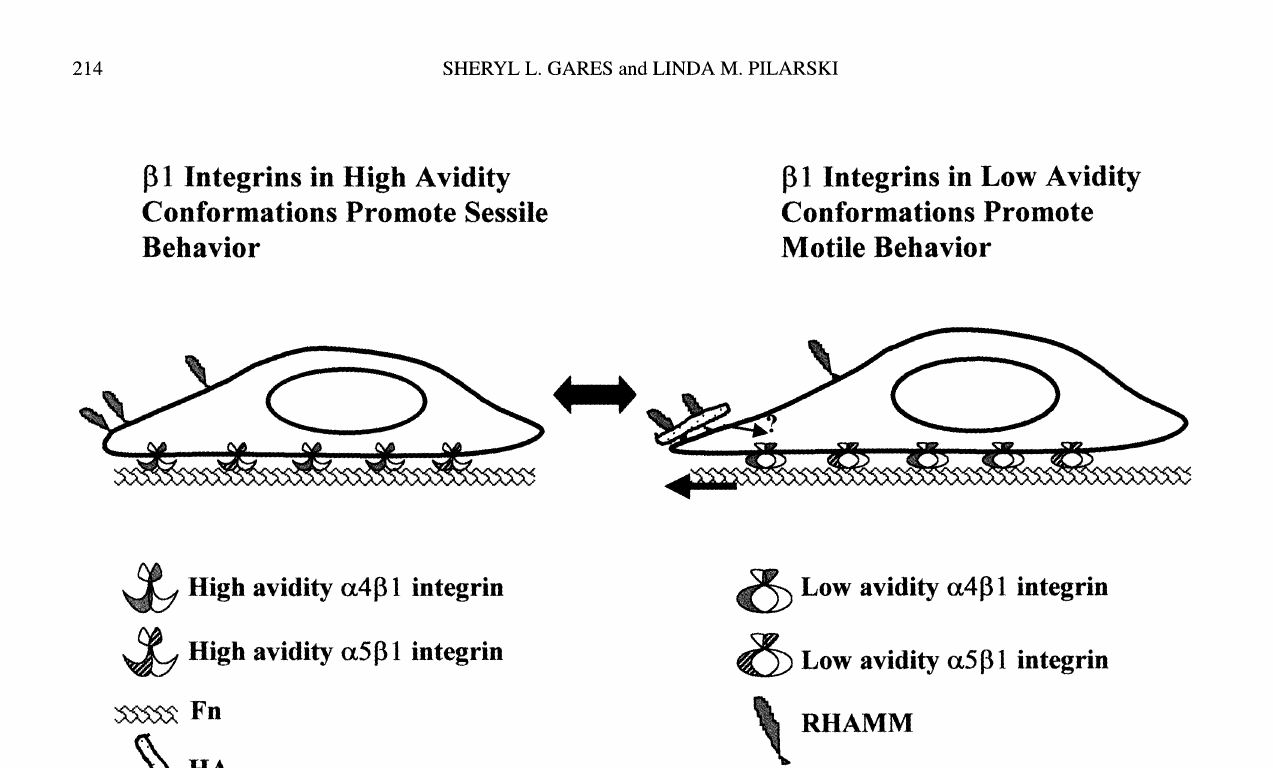
FIGURE The Balance Between Adhesion and Motility is Mediated by Integrin Avidity. When 4[ and 5 are in high avidity binding conformations, human thymocytes adhere strongly to Fn and sessile behavior predominates. HA binding to RHAMM may initiate signals that alter integrins to low avidity binding conformations. Integrins then maintain weakly adhesive contact with Fn, which promotes motile behavior. Thymocytes can revert to either behavior depending on signals received from stromal cells or the microenvironment during differ-